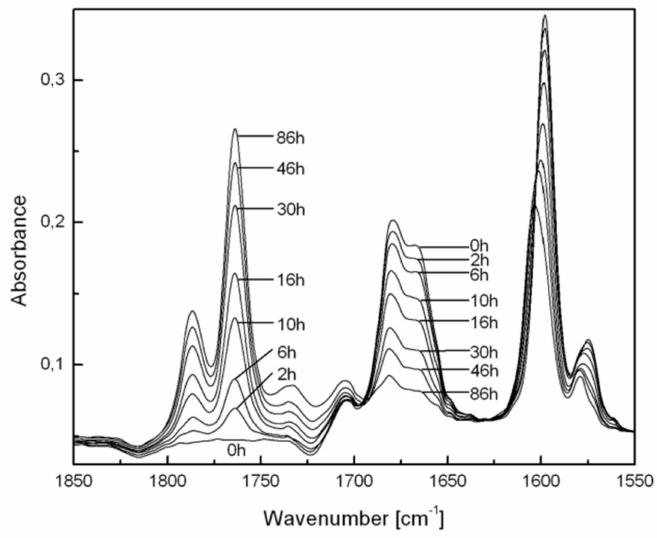
Figure 3. Changes in FTIR spectra of a BZS /S copolymer film during irradiation ( λ = 436 nm) at room temperature in air. The absorbance bands of PS have been subtracted for